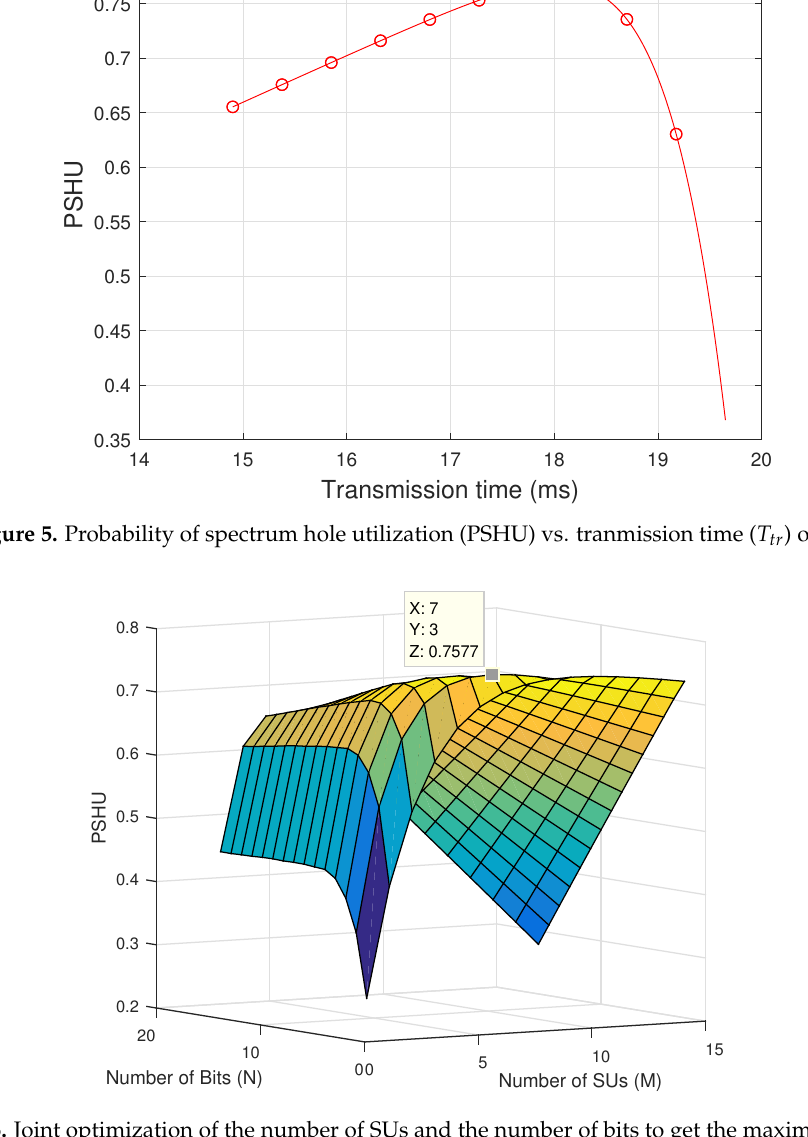
Figure 6. Joint optimization of the number of SUs and the number of bits to get the maximum